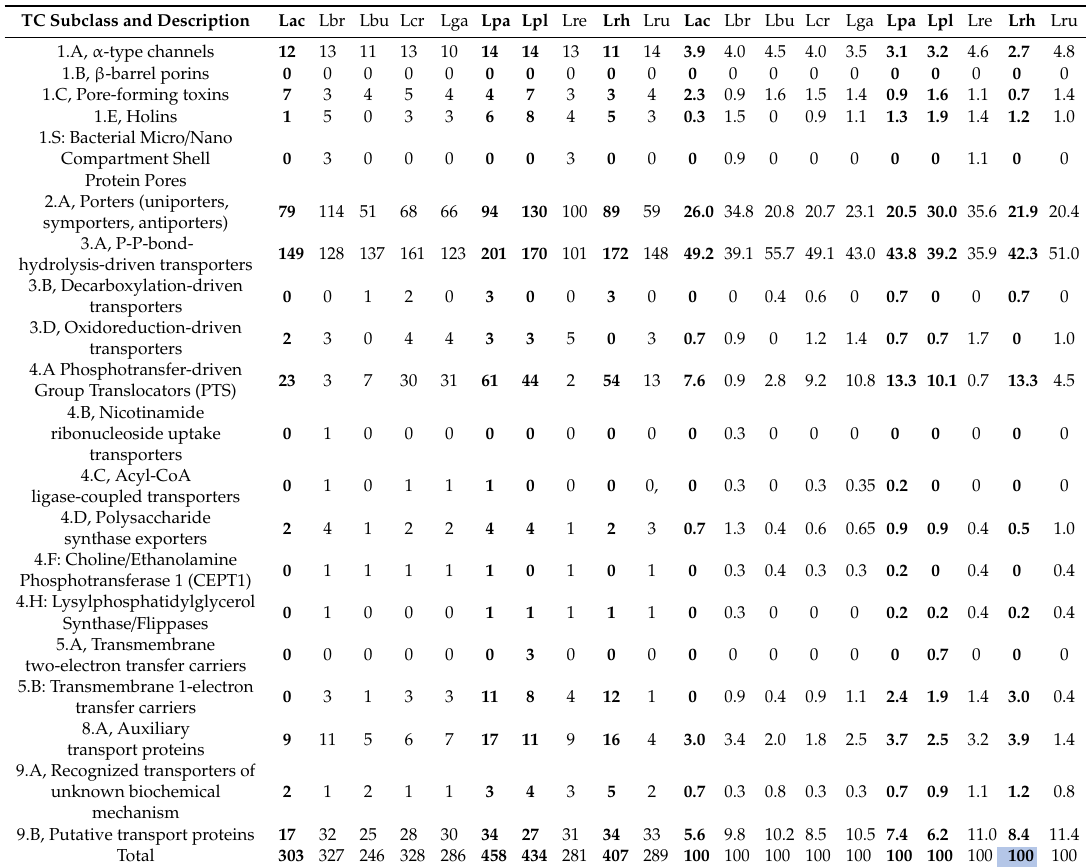
Table 2. Overview of Lactobacillus transport protein numbers (left) and percentages (right), based on TC subclass. PAP strains are in